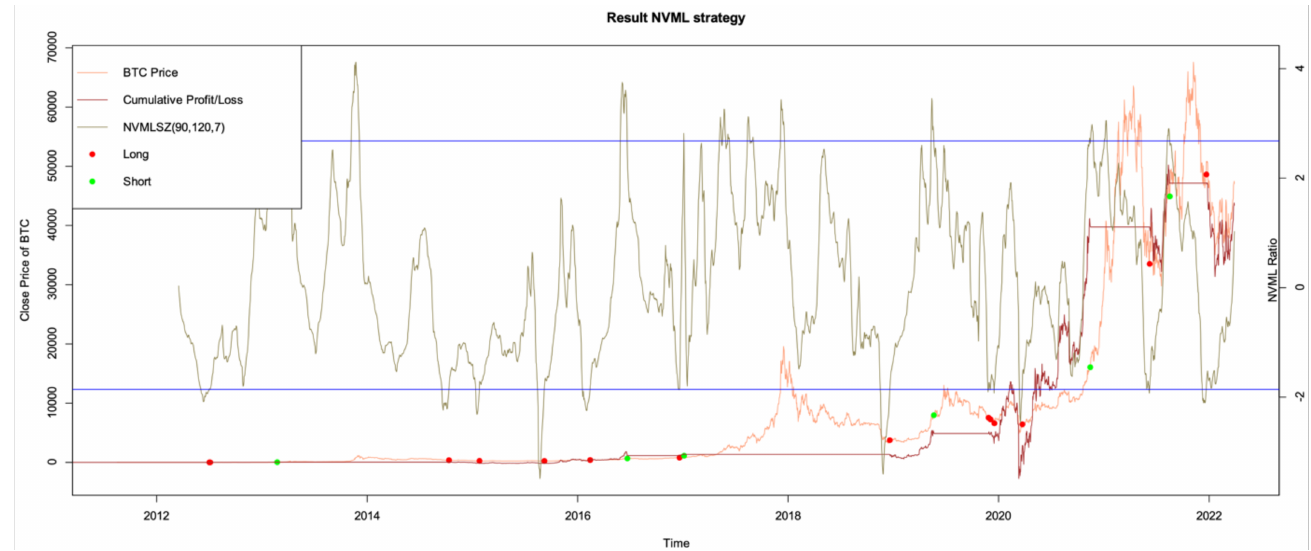
Figure A4. NVMLS-Z strategy: BTC price (orange line, left-hand side), cumulative profit/loss (red line, left-hand side), NVML S-Z ratio (brown line, right-hand side), long and short thresholds (blue lines, right-hand side), long orders (red points), and short orders (green